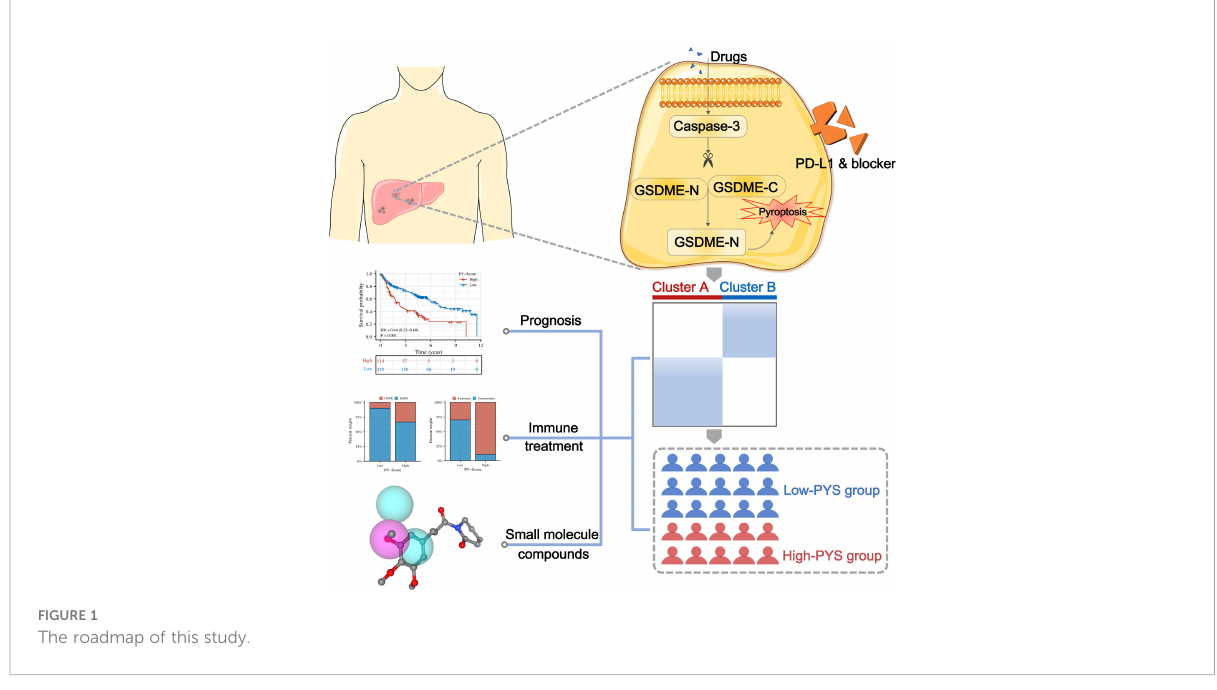
FIGURE 1 The roadmap of this study.